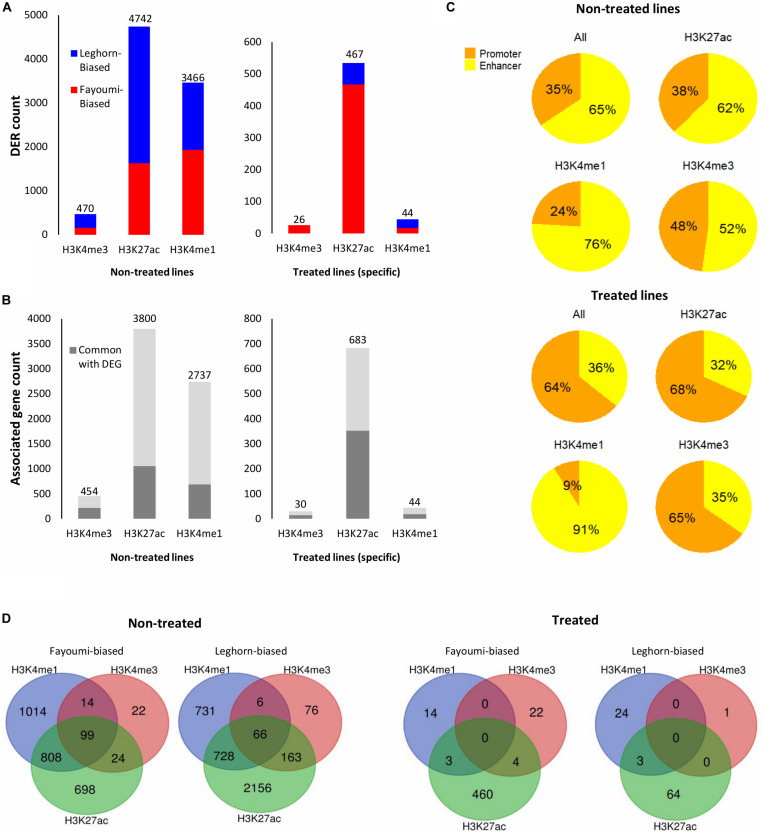
Summary of DER analysis for between-line comparisons. (A) Stacked bar plots showing the number of DERs with increased or decreased enrichment identified for each between-line comparison across all histone modifications. (B) Stacked bar plots showing the number of unique target genes associated with DERs and the number of associated genes that are in common with DEGs of the corresponding differential gene analysis (i.e., between non-treated lines or treated lines). (C) Pie charts showing the percentage of promoters or enhancers within the DERs of each histone modification. (D) Venn diagrams showing the overlapped DERs with similar line biases across histone modifications within each between-line comparison. DER, differentially enriched region; DEG, differentially expressed gene.